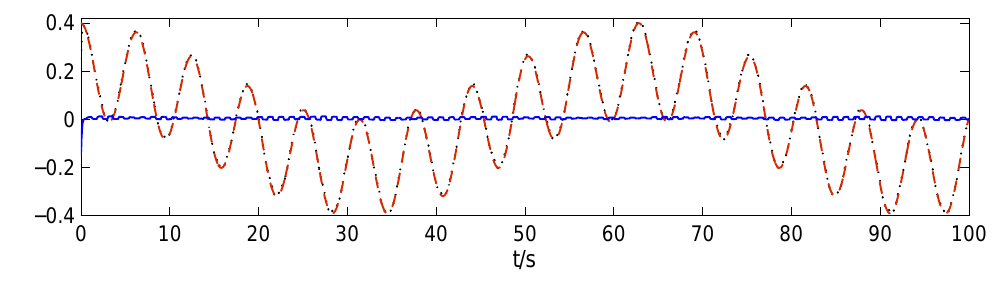
Figure 3. Tracking performance of output y